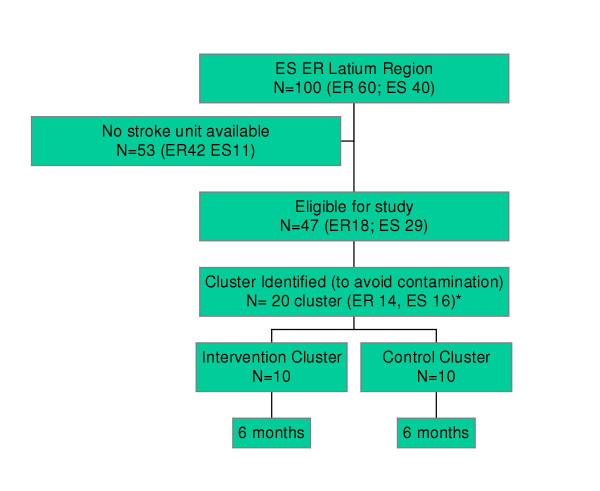
Flow chart of randomization procedure. Overall we had 20 units of randomization (cluster) of which 10 are couples composed of one ES+1ER on the basis of closeness (usually the ES is situated in the same place of the ER, or systematically refers patients in the same closest ER); 6 are ES and 4 are ER which could not be matched.